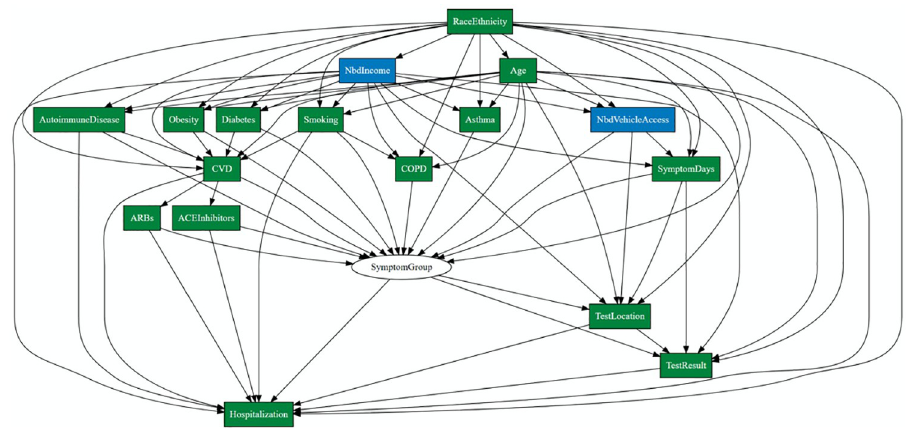
Fig 1. Hypothesized mechanistic model for racial, ethnic and socioeconomic mechanisms of COVID-19 testing location, test positivity and hospitalization.